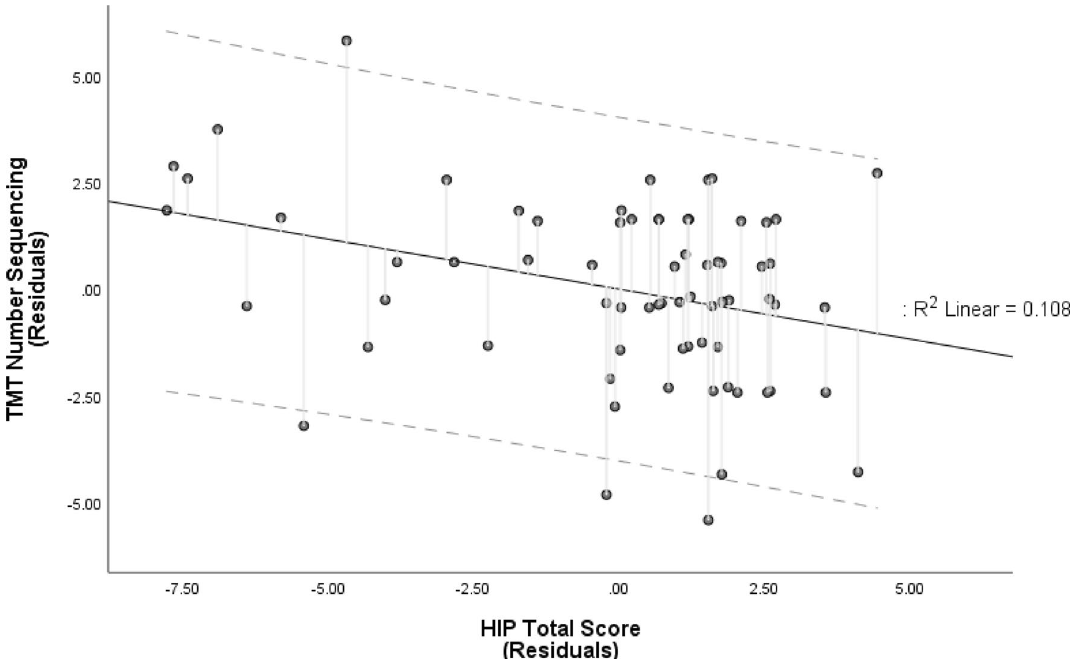
Figure 5. Partial regression plot of the model predicting Trail-Making Test (TMT) Number Sequencing Scaled Scores by Hypnotic Induction Profile (HIP) Total Score. The relationship between TMT Number Sequencing and the HIP total score, after controlling for age and years of education. HIP scores were the only significant predictor of TMT Number Sequencing scaled scores (higher scaled scores reflect faster completion times). The broken lines represent 95% prediction